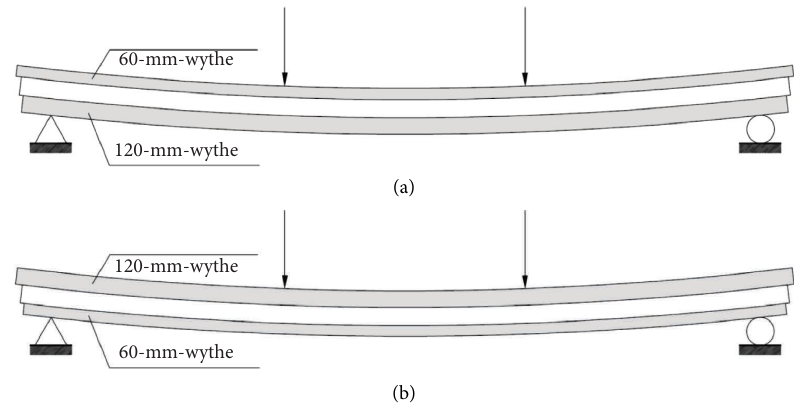
Figure 3: Diagram of deformed sandwich panels under (a) positive loads and (b) negative loads.